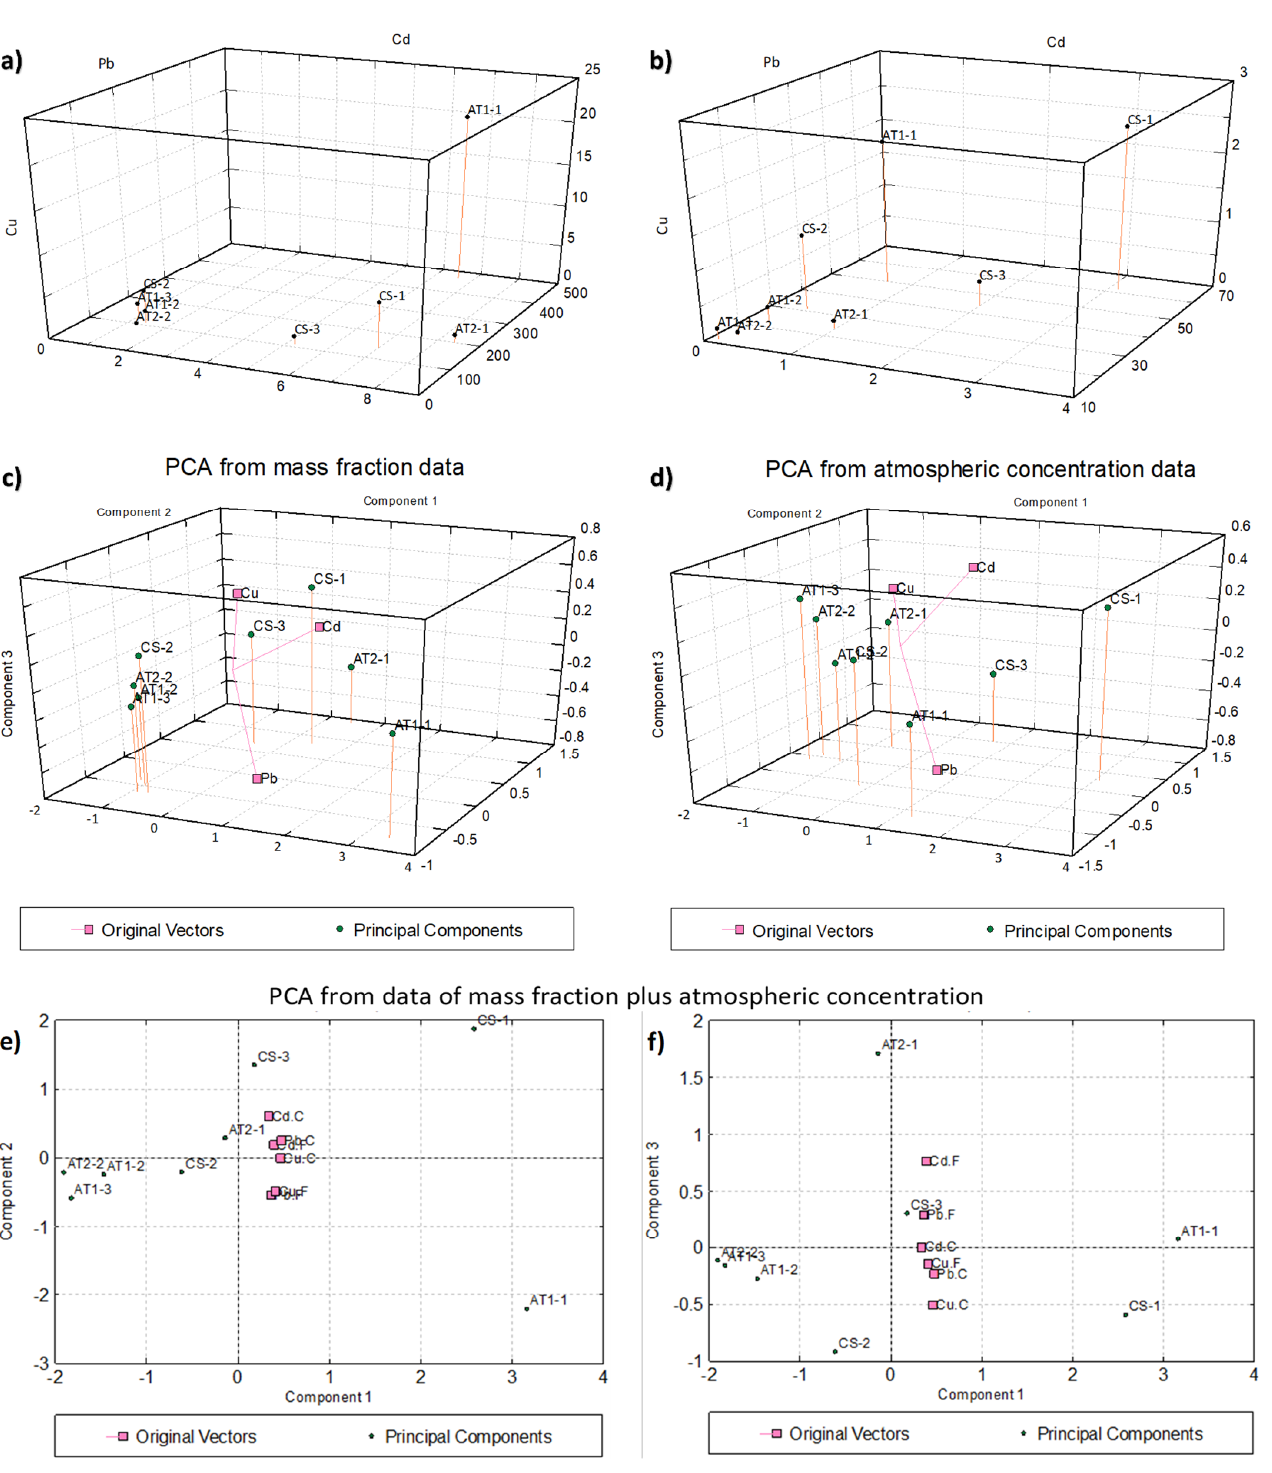
Figure 5. ( a , b ) 3D plots of original data in ( a ) mass fraction (Cd and Pb in µ g g − 1 , Cu in mg g − 1 ) and ( b ) atmospheric concentration (Cd and Pb in pg m − 3 , Cu in ng m − 3 ). ( c , d ) 3D PCA biplots from data in ( c ) mass fraction and ( d ) atmospheric concentration. ( e , f ) 2D PCA biplots from data in mass fraction (Cd.F, Pb.F, Cu.F) and atmospheric concentration (Cd.C, Pb.C, Cu.C) on the planes of ( e ) PC1 vs PC2 and ( f ) PC1 vs PC3. Squares: original vectors (PC loadings); circles: PC scores.